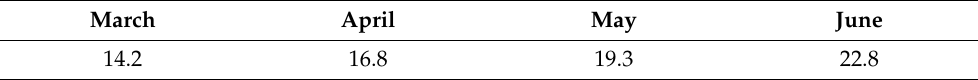
Table 1. Temperature media ( ◦ C) outside the greenhouse in the melon crop.